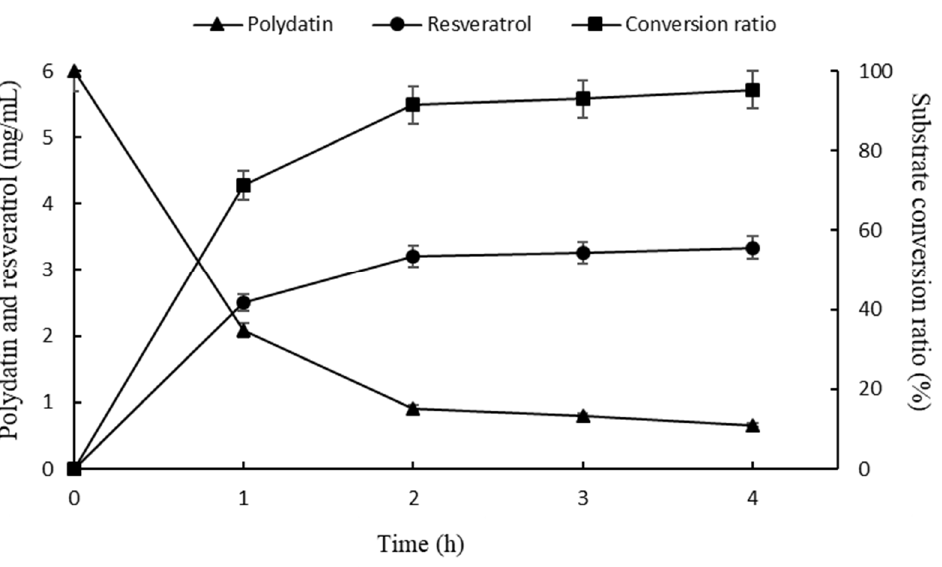
Figure 12. Time course of enzymatic transformation of crude polydatin and the deduced production of resveratrol. Each value in the figure represents the mean ± standard deviation ( n = 3).